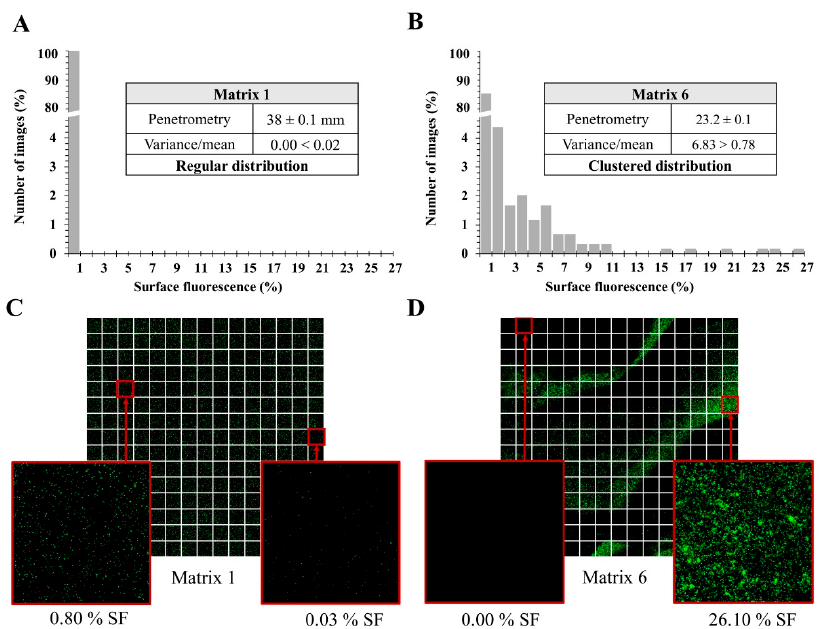
Figure 2. Frequency distribution of S. aureus CIP 4.83 surface fluorescence with the mean and the variance associated in ( A ) matrix 1 and ( B ) matrix 6, and a mosaic of 225 CLSM images in ( C ) matrix 1 and ( D ) matrix 6 Surface fluorescence (SF) has a threshold at 0.0005%.